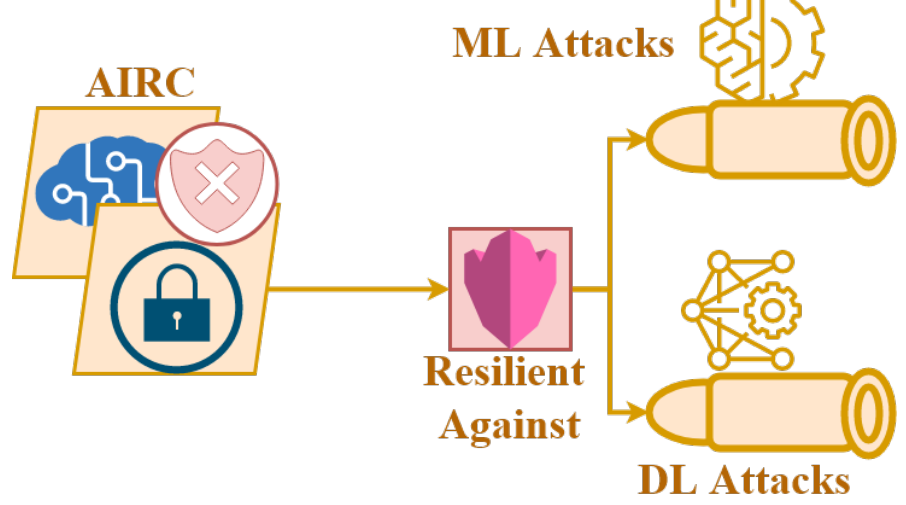
Figure 4. AIRC: Resilient Against ML and DL